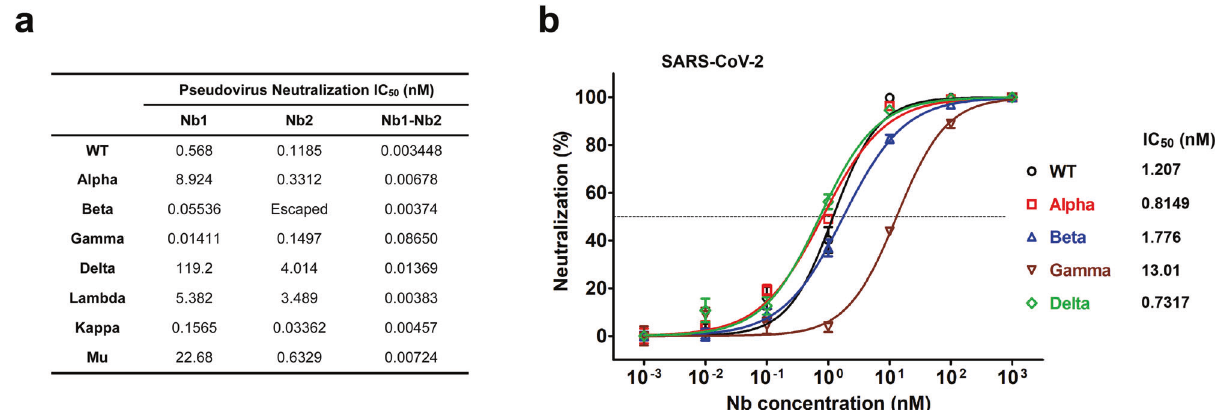
Fig. 4 Neutralization of SARS-CoV-2 VOC and VOI by monomeric and bivalent Nbs. a Neutralization of pseudotyped SARS-CoV-2 variants by Nb1, Nb2, or Nb1 – Nb2, respectively. Pseudovirus was pre-incubated with tenfold serially diluted Nbs before inoculation of Huh7 cells. At 48 h post infection, luciferase activities were measured, and percent neutralization was calculated. The experiments were performed independently at least twice, and similar results were obtained. One representative data of one experiment are shown and data were average values of three replicates ( n = 3). b Determination of neutralization ef fi cacy of bivalent Nb1 – Nb2 against recombinant SARS-CoV-2 GFP/ Δ N trVLP. The infected cells were subjected to fl ow cytometry analysis for quantifying the GFP fl uorescence at 2 days post infection. Error bars represent the standard deviations from three independent experiments ( n = (Supplementary Fig. S4), resulting in reduced vaccine effectiveness and activity loss of many neutralizing antibodies. 36,37 We fi rst measured the binding kinetic of different Nbs against Omicron RBD by BLI. Results showed that the tetravalent Nb1 – Nb2 – Fc